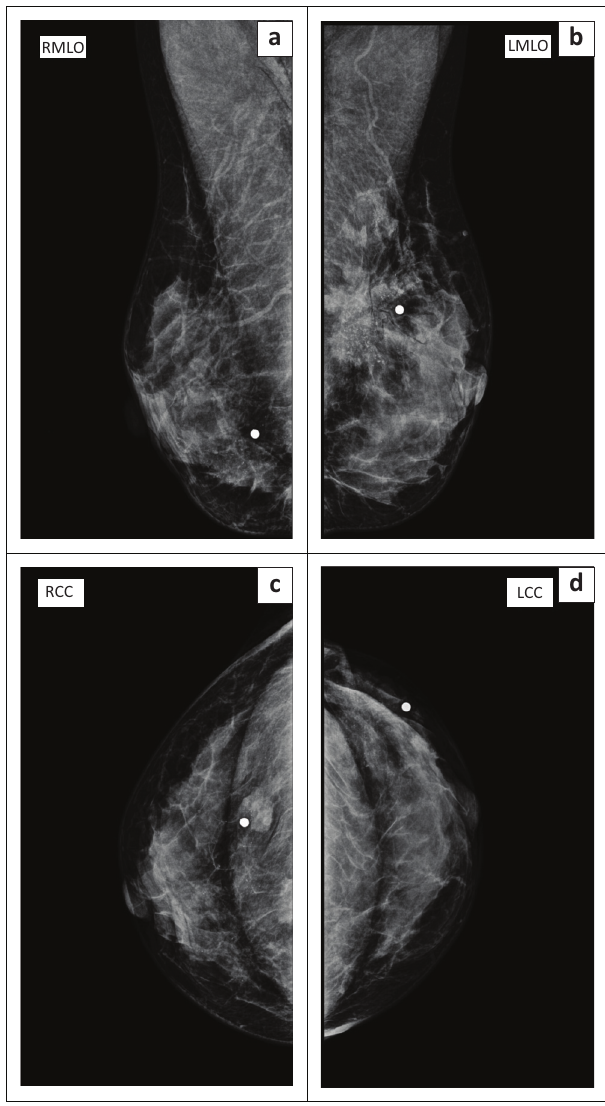
FIGURE 4: The right MLO (a), left MLO (b), right CC (c) and left CC (d) mammogram images of a 38-year-old woman who presented with a 3-year history of bilateral breast lumps. The skin markers demonstrate the site of the palpable lesion in each breast. In the central lower quadrant of the right breast, a focal soft tissue density is present with associated pleomorphic calcifications . In the left breast, there is a larger soft tissue density with spiculated margins, architectural distortion and pleomorphic calcifications in the upper outer quadrant. Both lesions were hypoechoic on ultrasound, with poorly defined margins and posterior shadowing. Ultrasound-guided core-needle biopsy demonstrated IDC in the right breast and ILC in the left breast; this histology was confirmed after